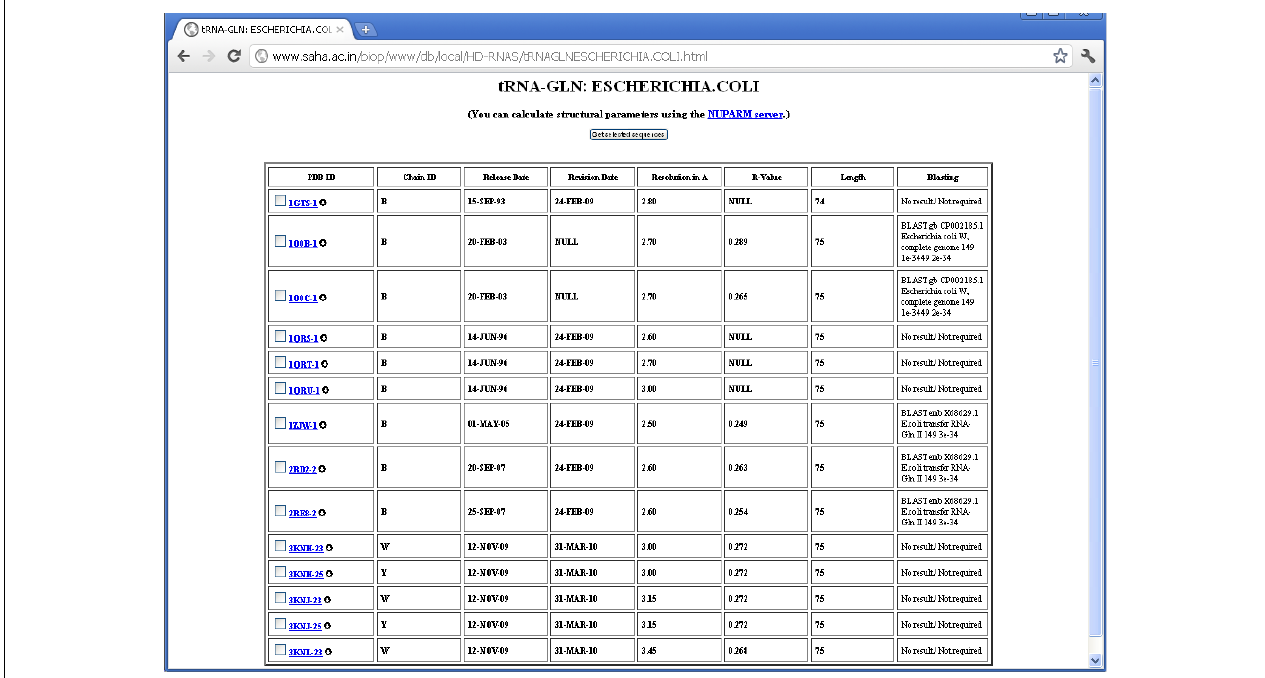
FIGURE 3 | BLAST search results for E. coli tRNA Gln